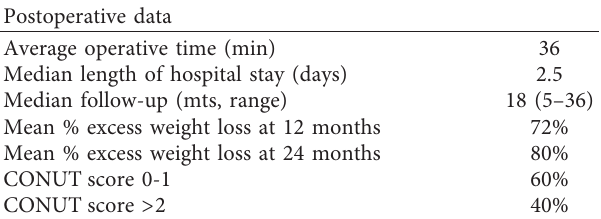
Table 2: Postoperative